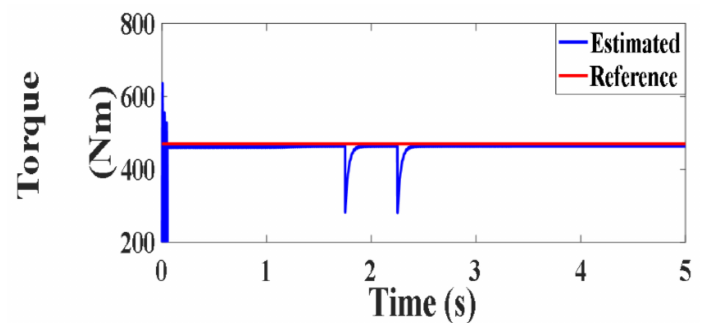
Figure 12. Developed torque under SVOC